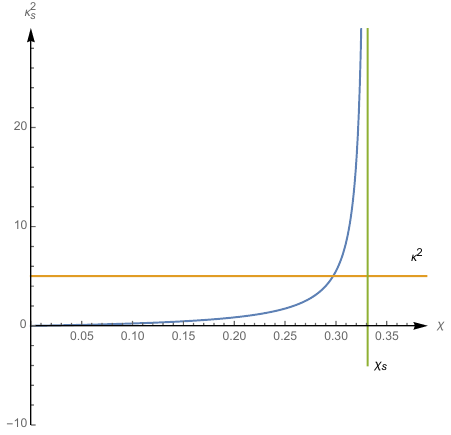
Figure 7. The blue curve illustrates the behavior of the critical (cid:13)ux in the interval [0 ; (cid:31) s ], where it exists. It is a monotonic function of (cid:31) and it ranges from 0 to 1